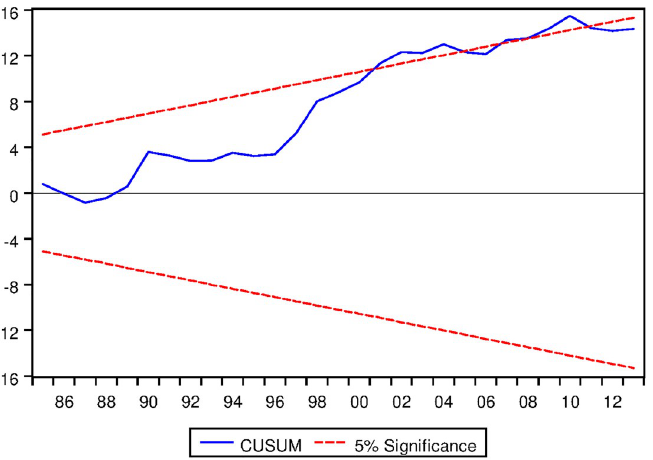
Fig 22. Stability diagnostic of cointegrating relationship for Korean data with no fixed regressor under proposed framework.